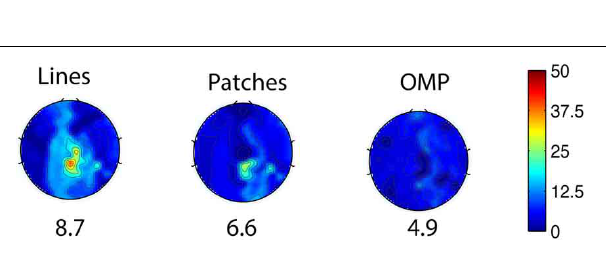
FIGURE 11 | Topographic BCG estimation error ( nRMSE ) maps in percentage (%) for different channel selection methods when the model building duration is 1min. The number at the bottom of each error map: the ave nRMSE averaged spatially across all channels.